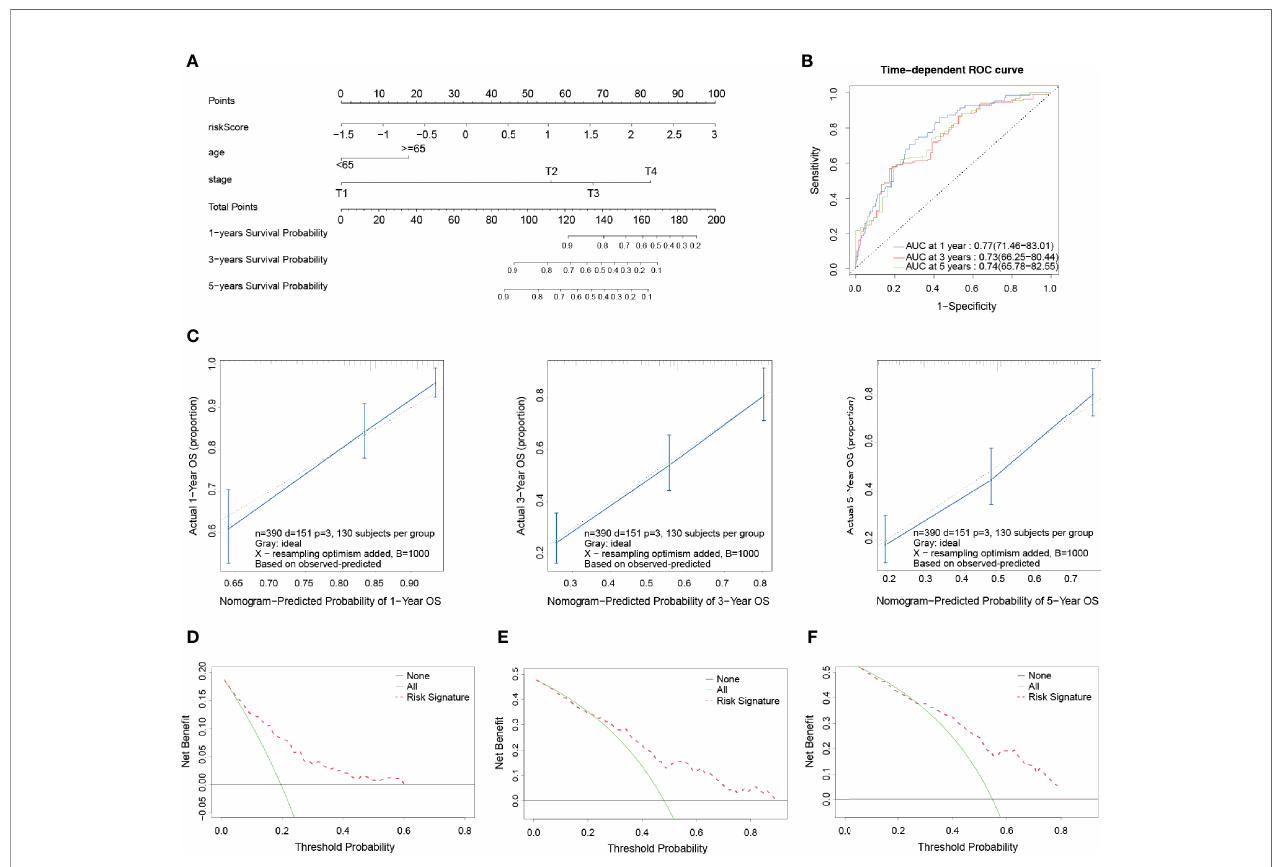
FIGURE 5 | Development and validation of a prognostic nomogram model. (A) Nomogram for predicting the probability of 1-, 3-, and 5-year OS. (B) Time- dependent ROC curves of the nomogram. (C) Calibration curves of the nomogram for predicting the probability of OS in 1-, 3-, and 5-year timeframes. (D – F) Decision curve analysis for the OS in BLCA patients at 1, 3, and 5 years,